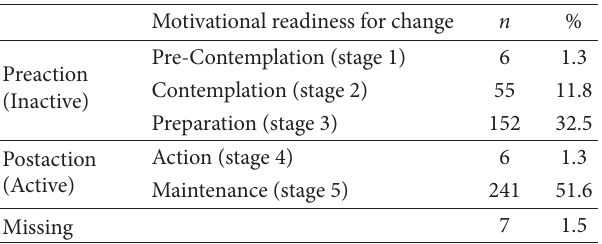
T 2: Proportions of women classi�ed across the stages of change (TTM) based on self-report